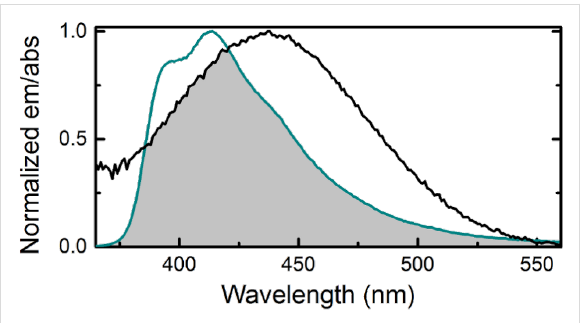
Figure 4: Spectral overlap between the emission of qAN1 (cyan) and the absorption of qA nitro (black) in dsDNA. The shaded region consti- tutes the overlap integral ( J